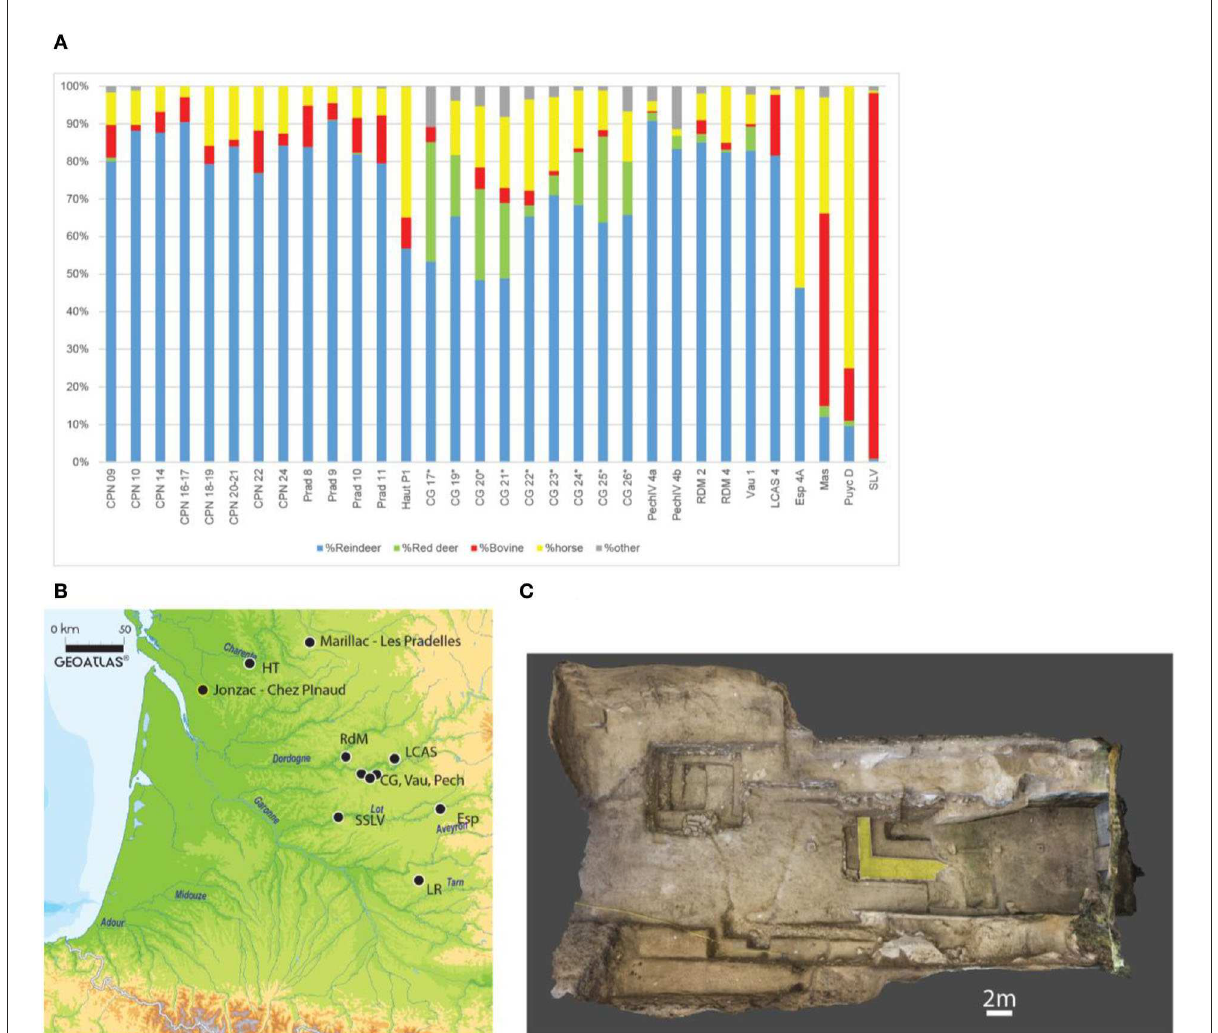
FIGURE1 (A, B) Distribution of the main Quina sites yielding faunal assemblages in Southwestern France, and contribution of the main prey to the faunal spectra (in %NR; Blue, reindeer; green, red deer; Red, Bison; Yellow, Horse; Gray, other). (A) CG, Combe Grenal (Laquay, 1981; Guadelli, 1987; Vau, Vauffrey (Delpech, 1996); PechIV, Pech de l’Azé IV (Niven, 2013); RdM, Roc de Marsal (Castel et al., 2017); LP, Les Pradelles (Costamagno et al., 2006); CPN, Chez-Pinaud-Jonzac (Airvaux, 2004; Jaubert et al., 2008b; Niven, 2013); LCAS, La Chapelle-aux-Saints (Rendu et al., 2014); Haut, Hauteroche (Paletta, 2005); LR, La Rouquette (Rendu et al., 2011); SLV, Sous les Vignes (Turq et al., 1999); ESP, Espagnac (Jaubert, 2001). Numbers correspond to the different stratigraphic units. For Combe Grenal Reindeer was under-evaluated in the previous excavation due to selective sampling. Derived from Discamps and Royer, 2017. Map from Geoatlas. (C) Orthophotography of the site, extracted from the 3D model. In yellow, the 2019–2021 excavation